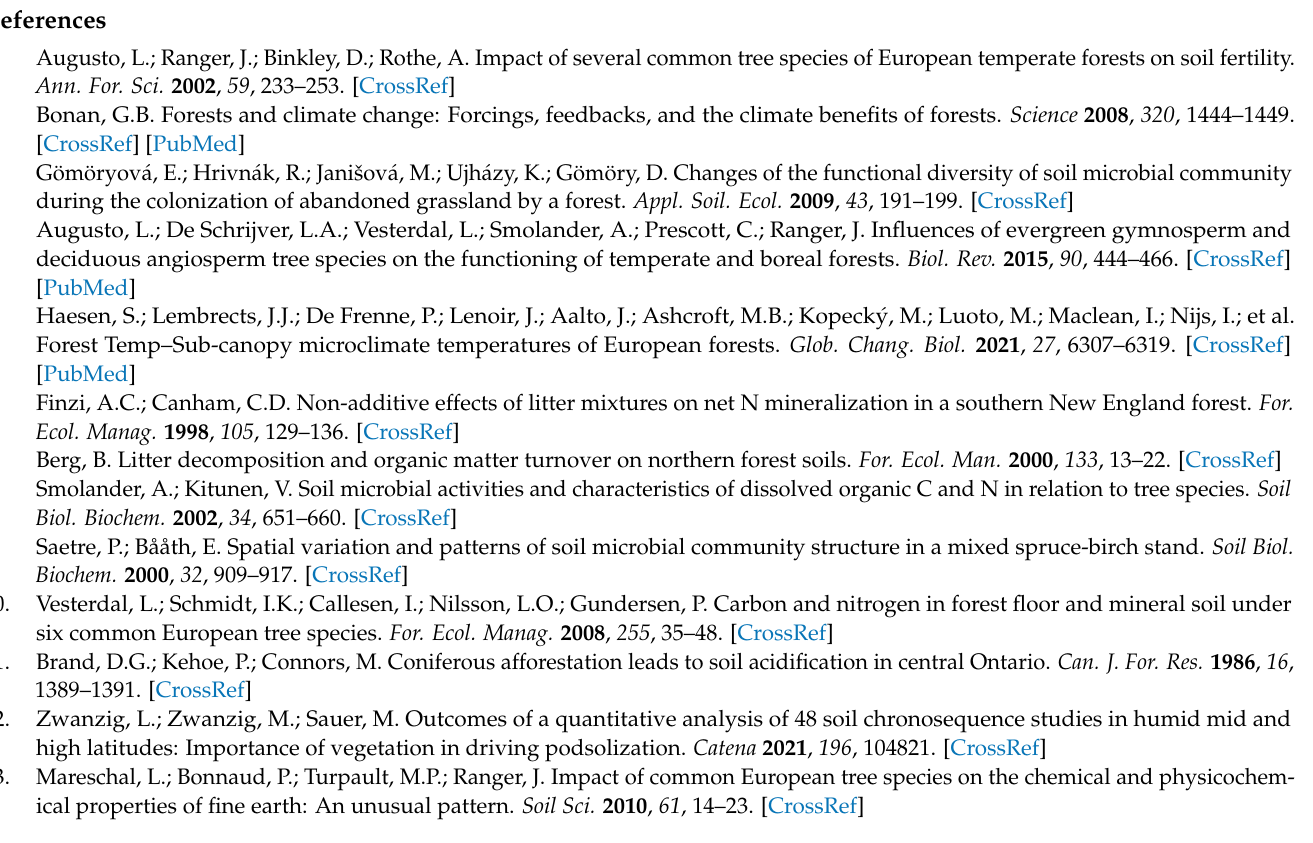
Table S1: Means and results of Tukey’s HSD tests for differences between tree species of microbial activity of functional groups (utilization of different carbon